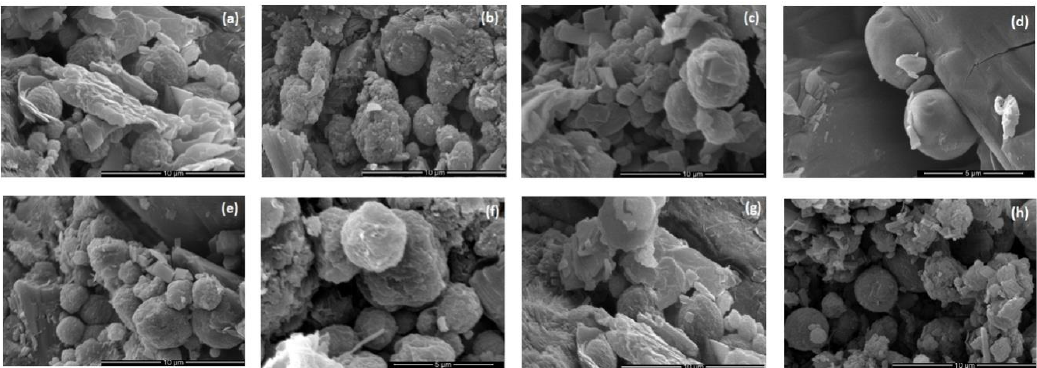
Figure 3. SEM pictures of ODMT cross-sections: ( a ) formulation F3, ( b ) formulation F4, ( c ) formulation F7 under magnification 10,000 × , ( d ) formulation F8 under magnification 50,000 × , ( e ) formulation F11 under magnification 10,000 × , ( f ) formulation F12 under magnification 50,000 × , ( g ) formulation F15, ( h ) formulation F16 under magnification 10,000 ×.